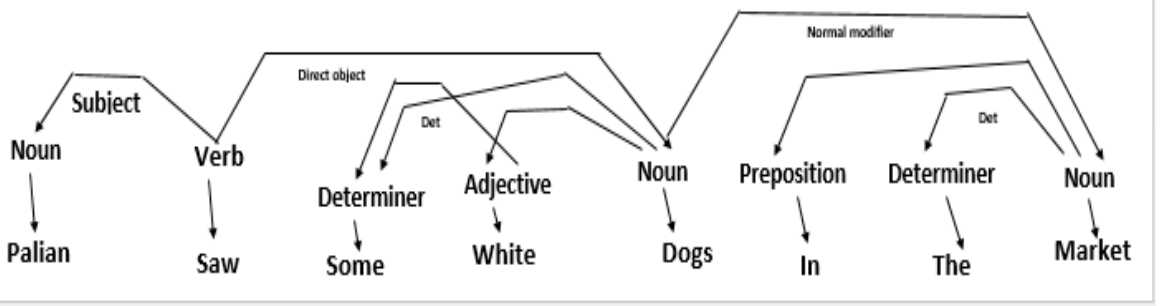
Figure 12. Text extraction and target adverts based on the audience’s choice of words.